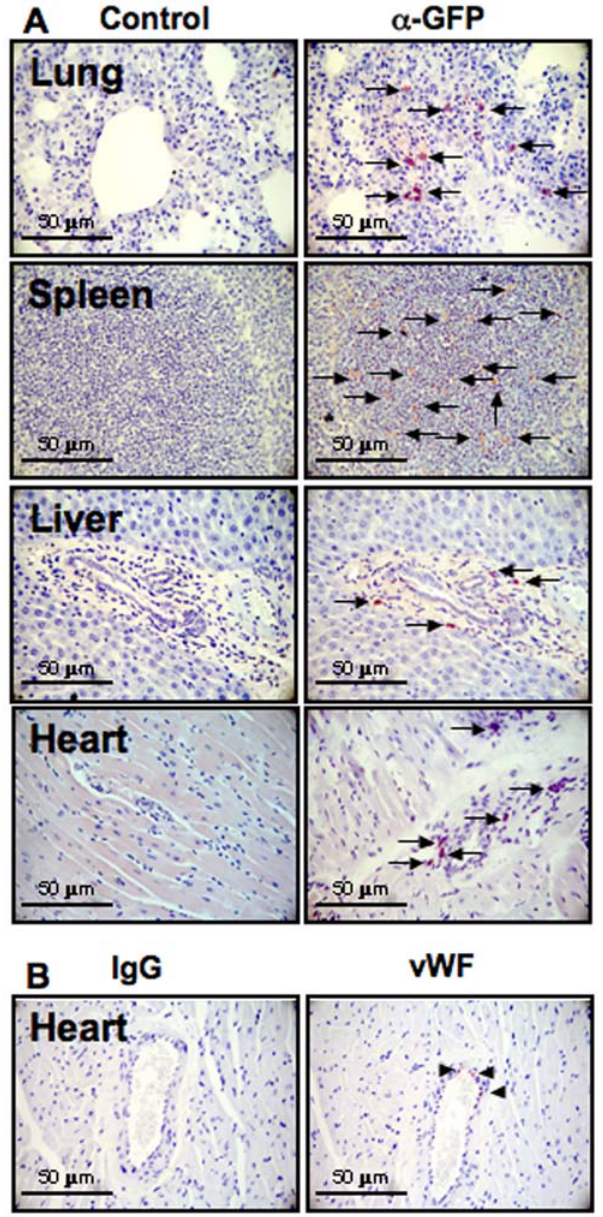
Figure 5. Detection of stem cell homing. (A) Immunohistochemical detection was performed 36 hours after half a million of GFP overexpressed nanofiber expanded stem cells injected into the left ventricle of the rats, with fixed and paraffin embedded tissue sections from various organs using anti-GFP Ab (right panels) against respective controls (left panels) confirming stem cell homing to lung, spleen, liver and heart. (B) Heart sections were stained for human specific von Willebrand factor (vWF) and immunoglobulin G (IgG) as a